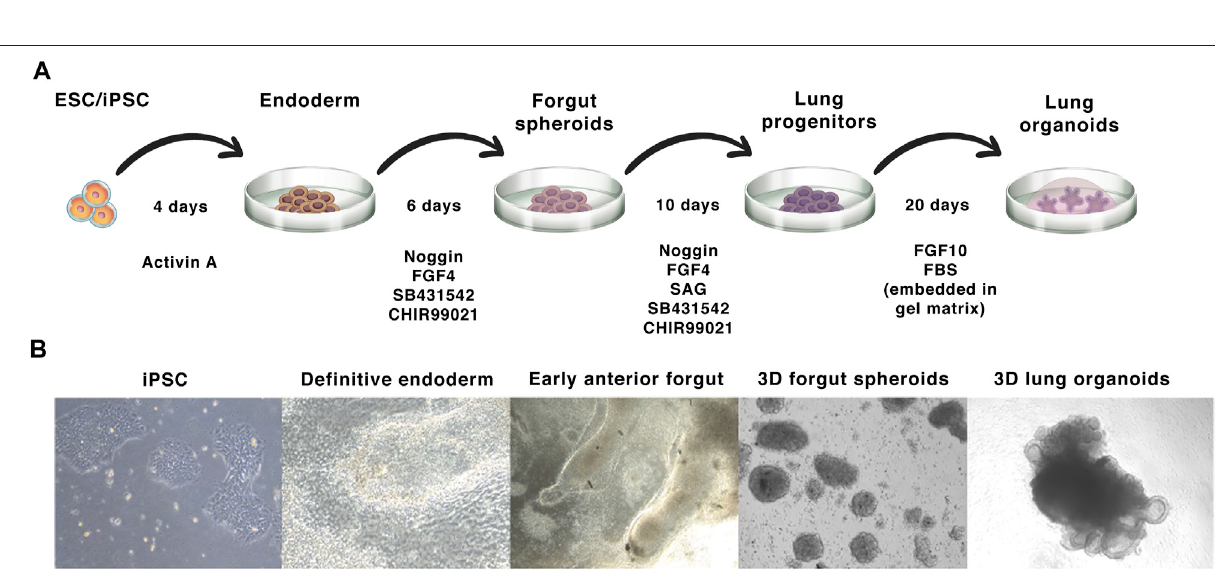
FIGURE 3 | iPSC-derived lung organoid differentiation: (A) — The protocol starts with the induction of iPSC colonies to form the de fi nitive endoderm, which is then differentiatedintoforegutspheroids.ThesespheroidsarethenembeddedinagelbasalmatrixandfurtherdifferentiatedintoLOs. (B) — Bright- fi eldimagesofthedifferent stages of LO development from